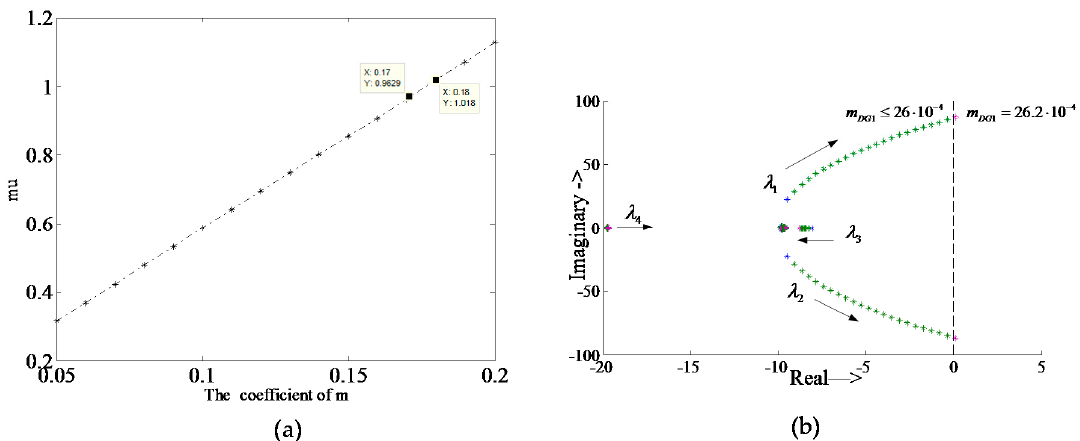
Figure 13. ( a ) Value of µ ∆ ( G MG ( s )) for size coefficients λ m _ DG 1 and n DG 1 = 1 × 10 − 3 ; ( b ) dominant eigenvalues for the MG with 0 ≤ m DG 1 ≤ 26.2 × 10 − 4 and n DG 1 = 1 × 10 − 3 .